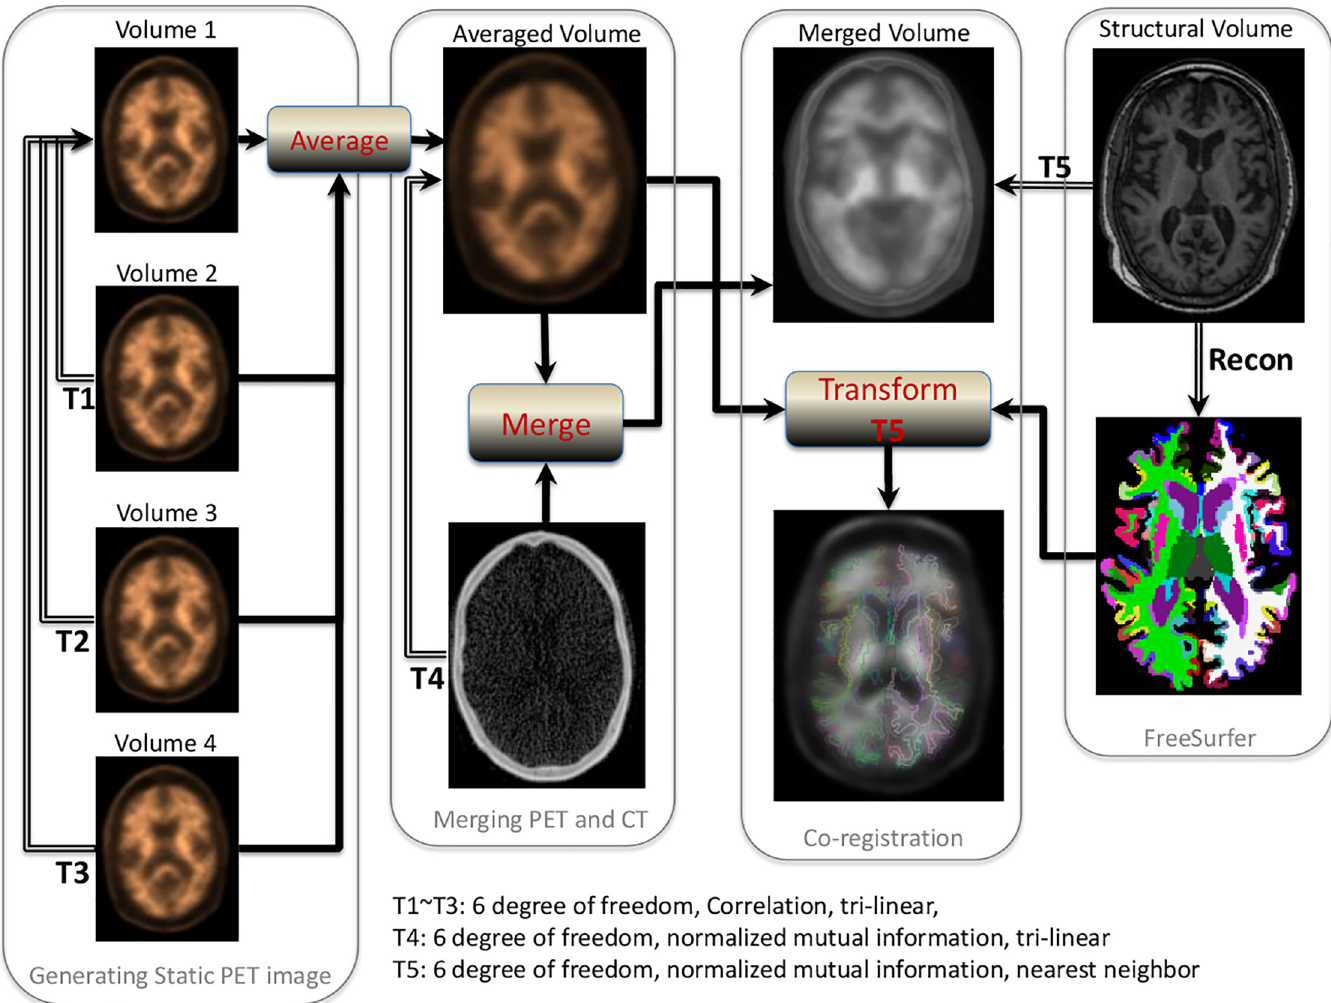
Fig 1. Procedures for quantitative PET amyloid